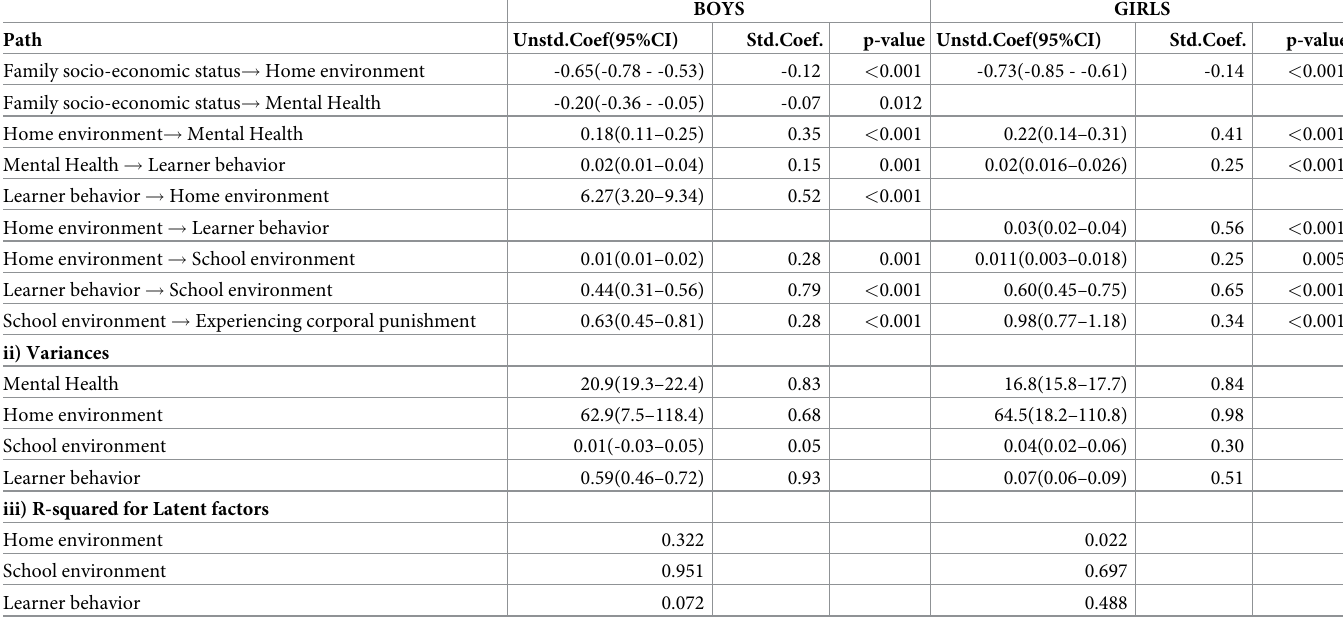
Table 4. Pathways to experiencing corporal punishment at school for boys and